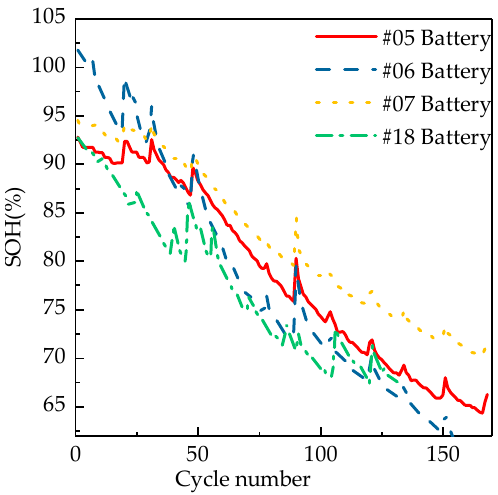
Figure 5. The SOH degradation with the cycle of batteries #5, #6, #7, and #18.